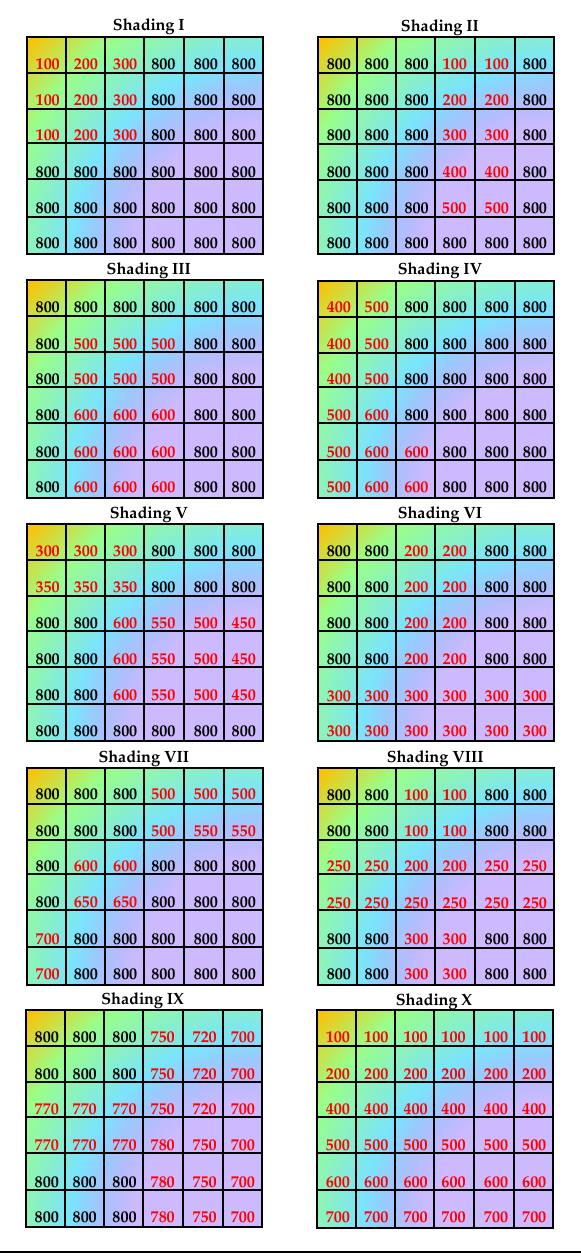
Figure 16. Random partial shading cases for the 6 × 6 PV array.